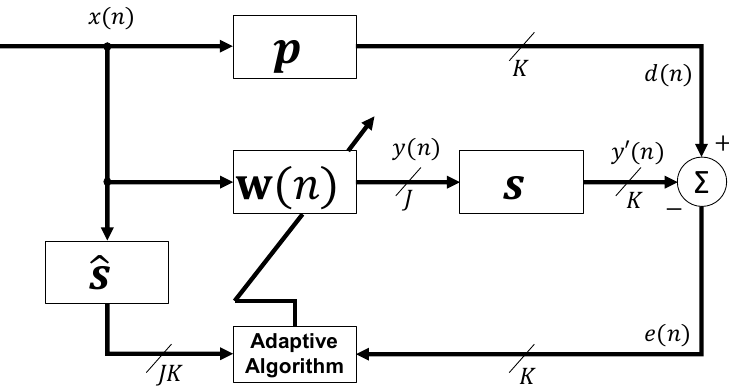
Figure 1. Block diagram of the conventional filtered-x multichannel active noise